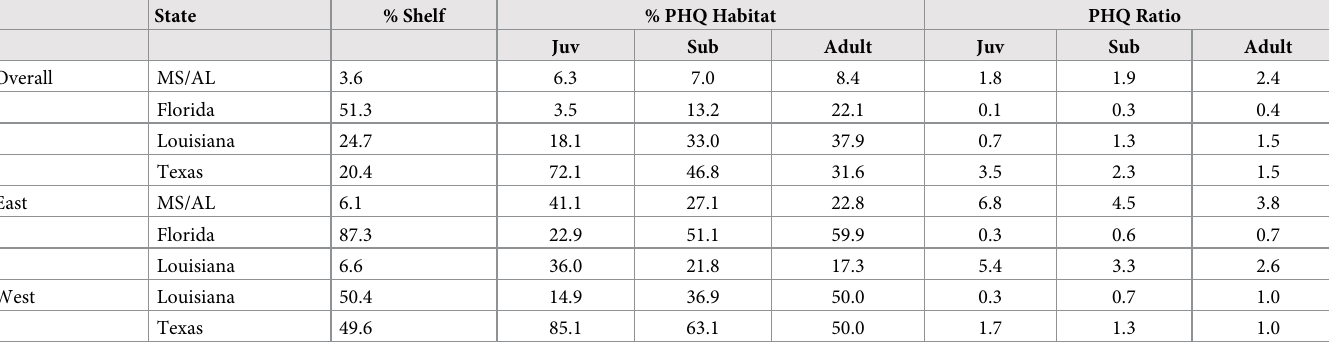
Regions include Mississippi/Alabama (MS/AL), Florida, Louisiana, and Texas. Metrics are shown for each region in relation to the overall, eastern (East), and western (West) U.S. GoM. % Shelf is the percent of the shelf that falls within a region. % PHQ Habitat is the percent of the total predicted high quality (PHQ) habitat for each red snapper age class within a region. PHQ Ratio is an index of relative habitat suitability expressed as the ratio of % PHQ Habitat to % Shelf. Age classes include juvenile (Juv; age-0), sub-adult (Sub; age-1-2), and adult